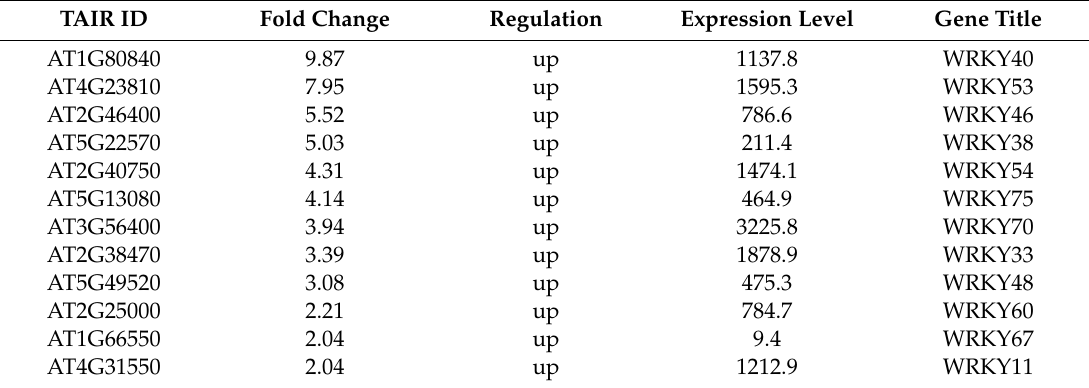
Table 1. WRKY transcription factor genes that exhibit a more than 2-fold change in atr8 . TAIR ID Fold Change Regulation Expression